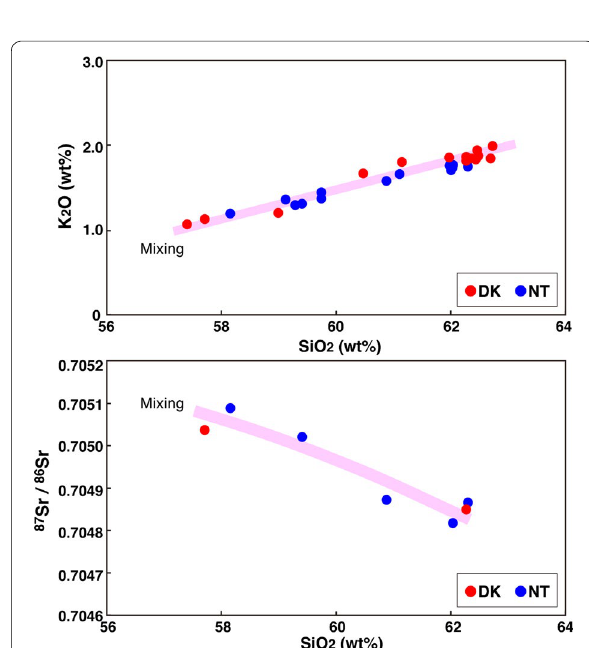
Fig. 19 K 2 O vs. SiO 2 and 87 Sr/ 86 Sr vs. SiO 2 diagrams for the products of Adatara Volcano. Note that the mafic magma is more enriched in Sr isotope than the felsic one. Data are from this study (Additional file 4: Appendix